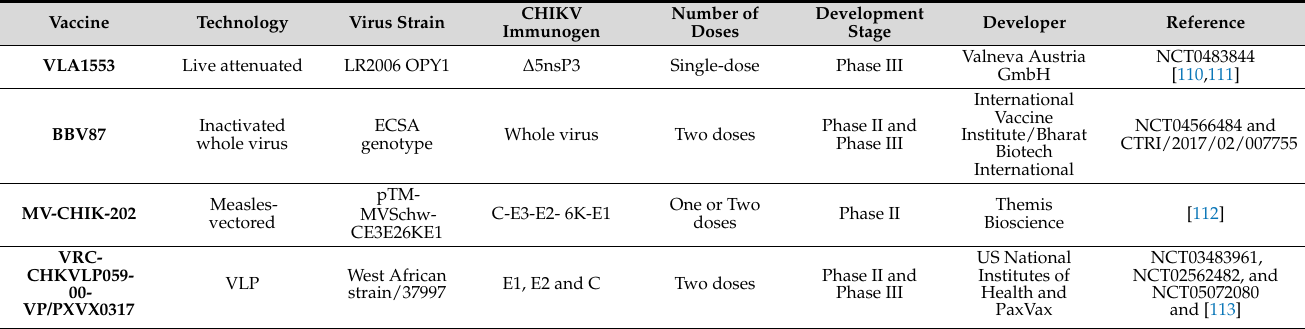
Table 1. Summary of all the current vaccines under a clinical trial evaluation, either Phase I/II or Phase III. These vaccines are discussed in more detail